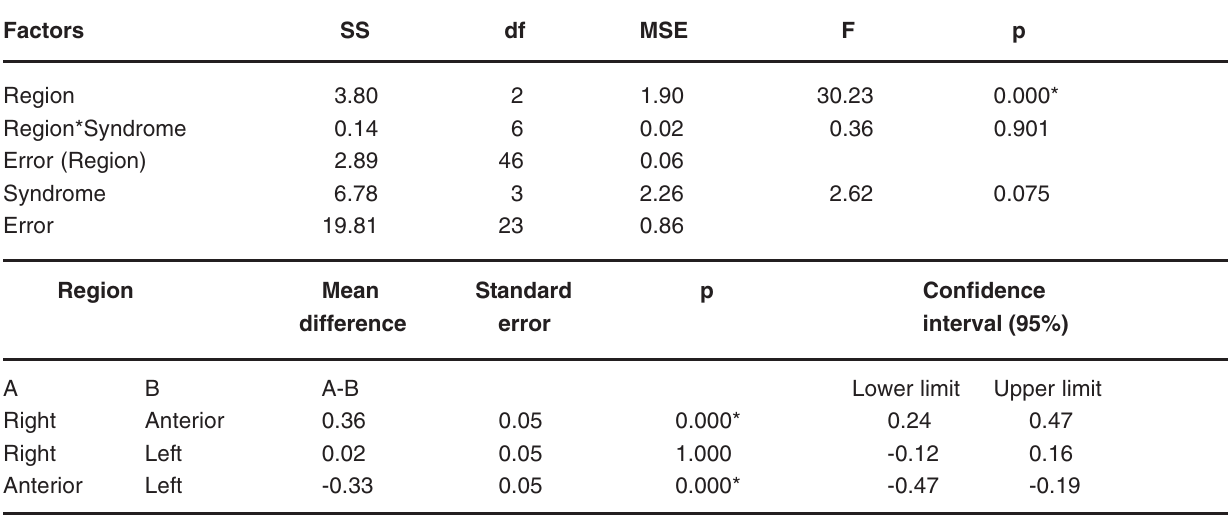
TABLE 2- Comparison of probing depth according to region and syndrome (ANOVA)